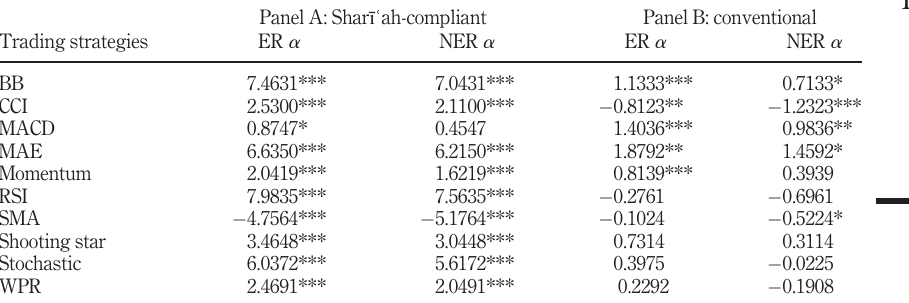
Table IV. Summary results